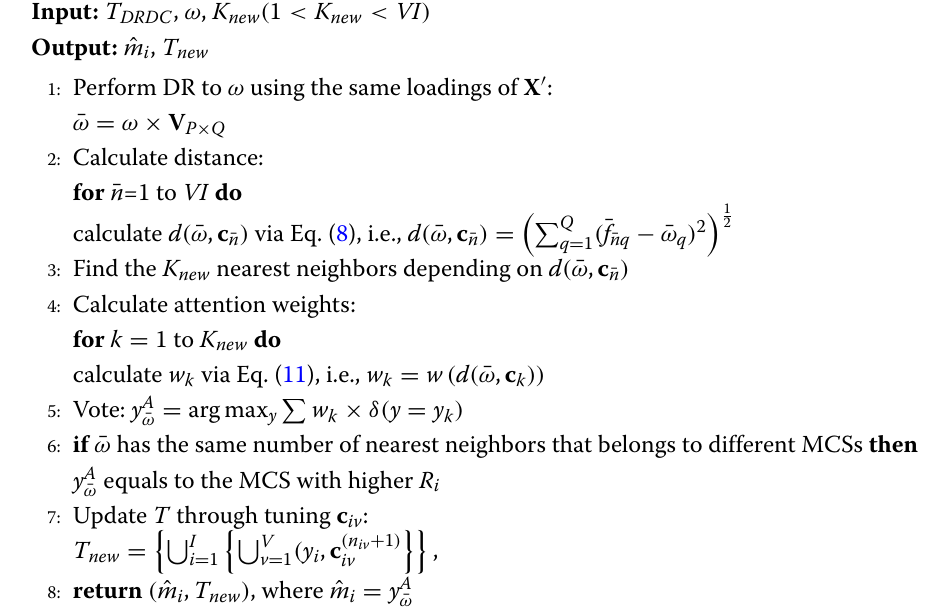
Algorithm 2 Online learning DRDC-A- k NN based